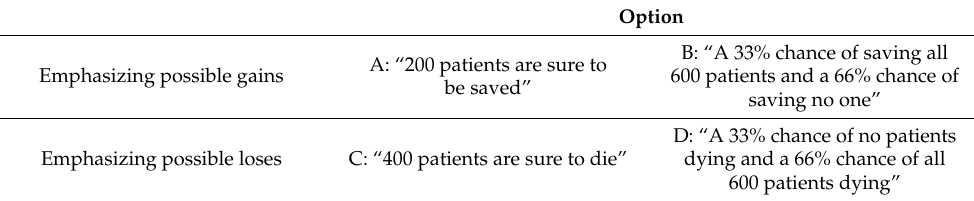
Table 1. Two hypothetical situations explaining prospect